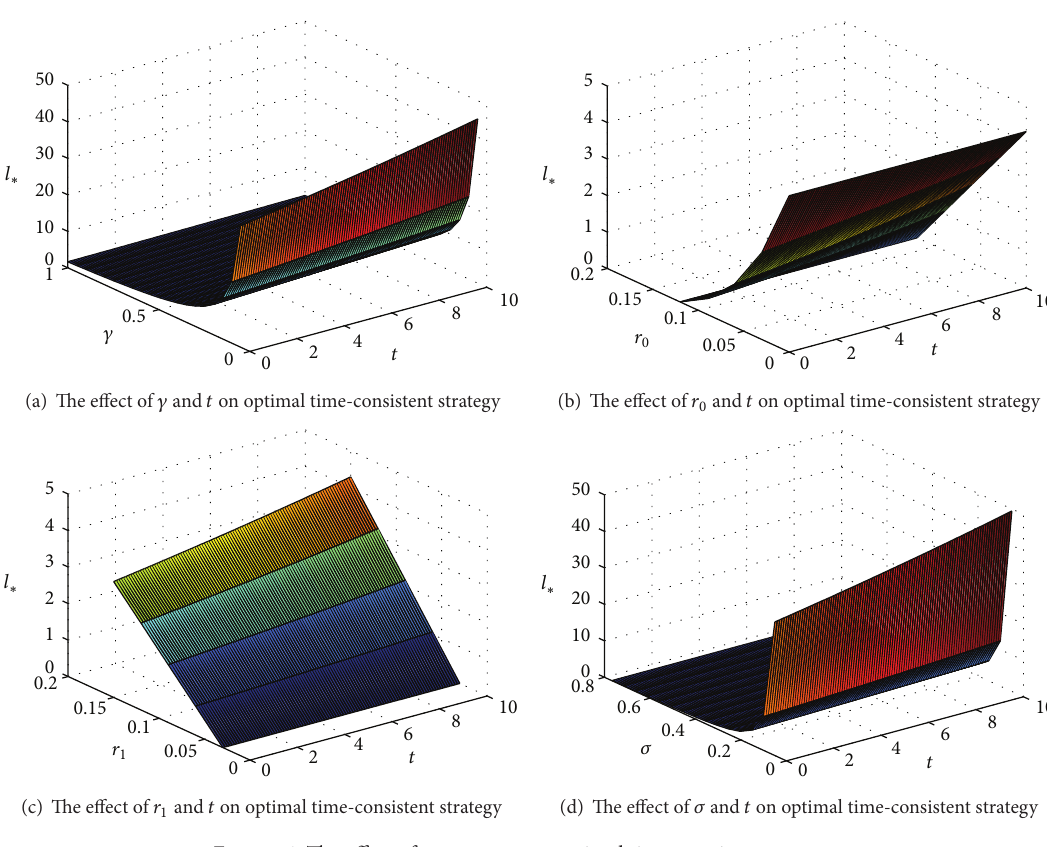
Figure 4: The effect of parameters on optimal time-consistent